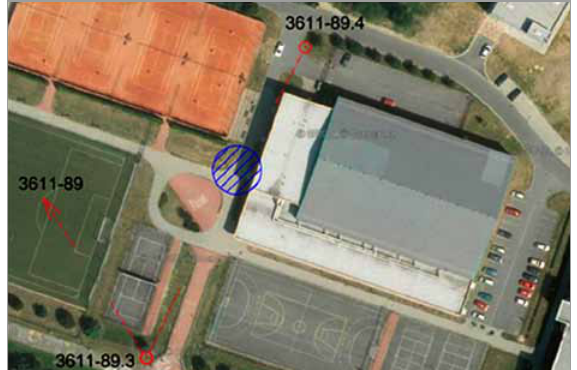
is the actual height of the building (reflective